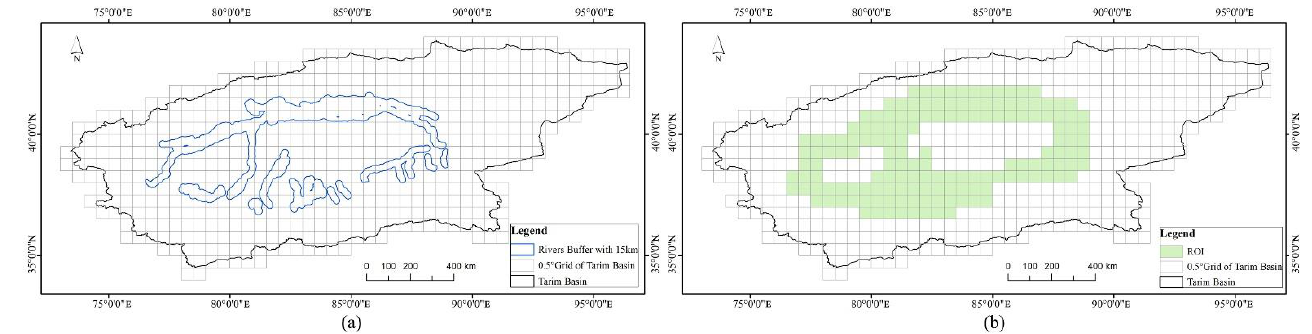
Figure 3. Sketch maps of ROI based on the geographical distribution characteristics of P. euphratica . ( a ) 0.5° × 0.5° grid layer overlapped with river buffer layer; ( b ) real ROI.